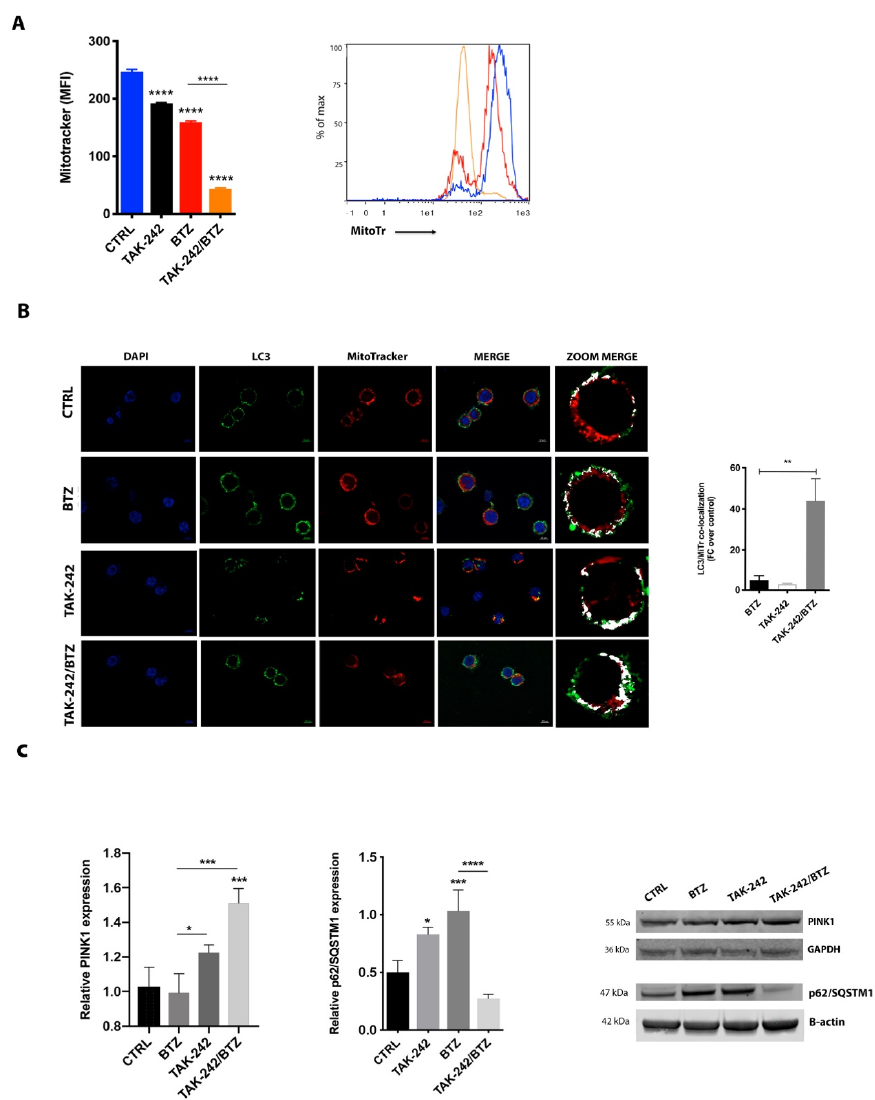
Figure 6. The combination of TAK-242/BTZ activated mitophagy. ( A ) Flow cytometric analysis of U266-R for mitochondrial mass 24h post-treatment as determined by MitoTracker Red fluorescence. A representative histogram of MitoTracker staining (right panel) is shown. ( B ) Immunofluorescence for the colocalization of LC3 (green) and MitoTracker (red) in U266-R after 24h treatment with BTZ and its combination with TLR-4 inhibitor. Counterstaining of cells was performed by using the nuclear dye, DAPI (blue). Quantitative analysis of the colocalization of LC3 with MitoTracker was plotted (right panel). FC = fold changes. Scale bar: 10 μ m ( C ) Analysis of PINK1 and p62/SQSTM1 protein expression after drug treatments for 24h. β -actin or GAPDH proteins were used as total protein loading reference. For analysis of Western blot, the optical density of the bands was measured using Scion Image software (https://imagej.net/Fiji). All showed results represent the means of